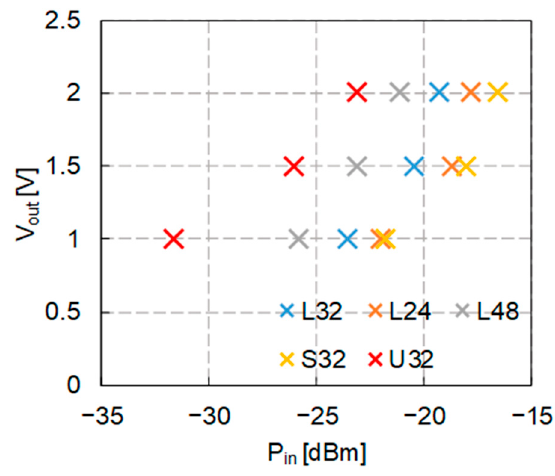
Figure 12. Sensitivity at different V out with a load resistance of 10 G Ω .